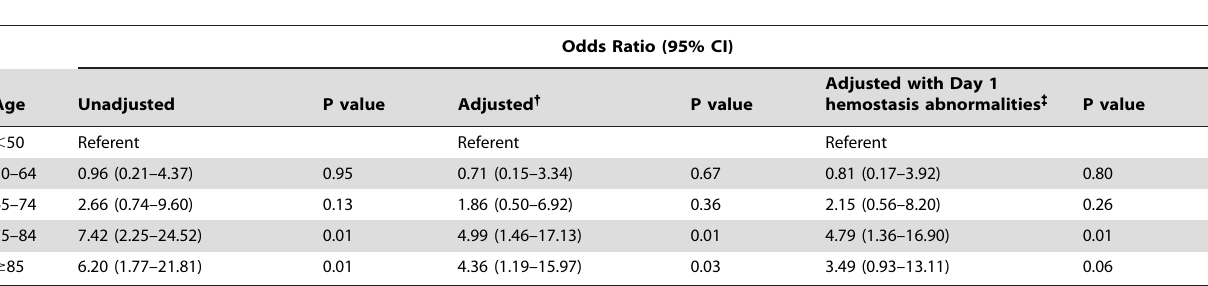
Table 5. Unadjusted and adjusted odds ratios for association between age and mortality at 90